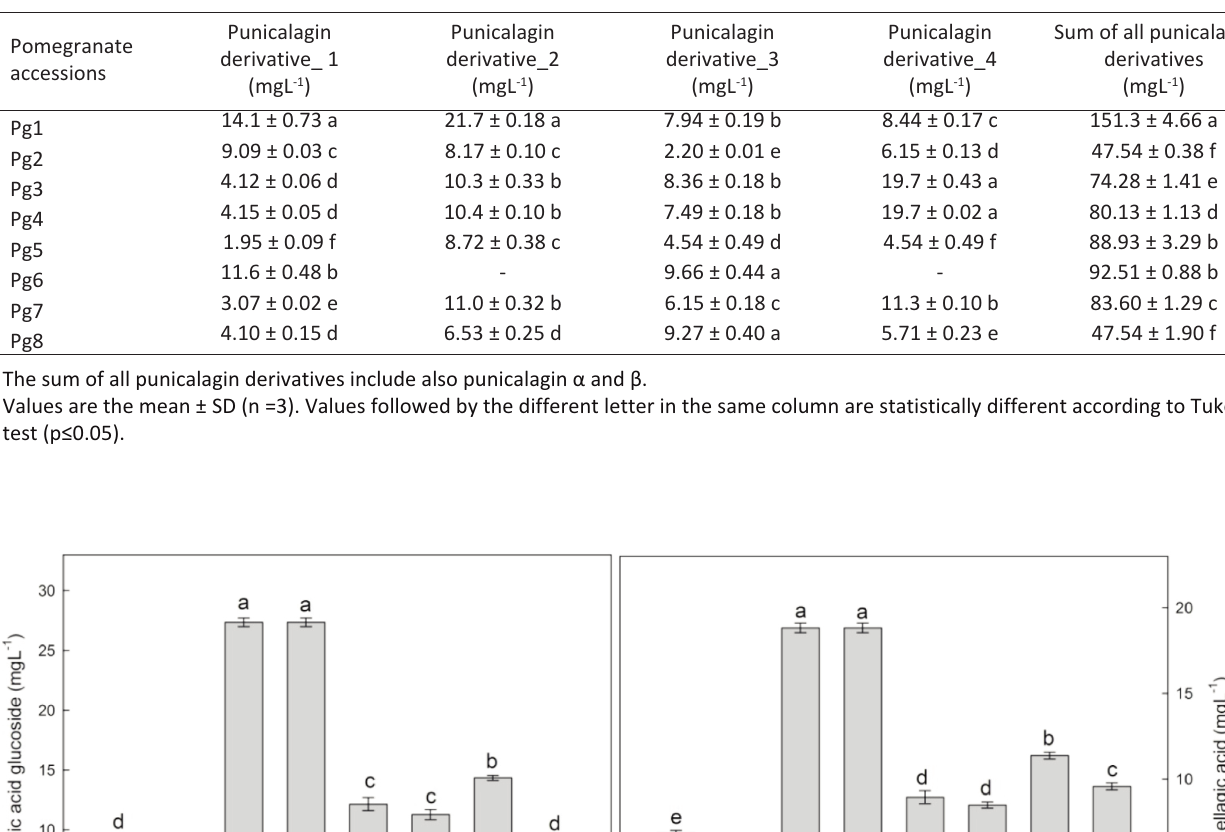
Table 2 ­ Content of four punicalagin derivatives in the juices obtained from pomegranate fruits harvested in each sampling area